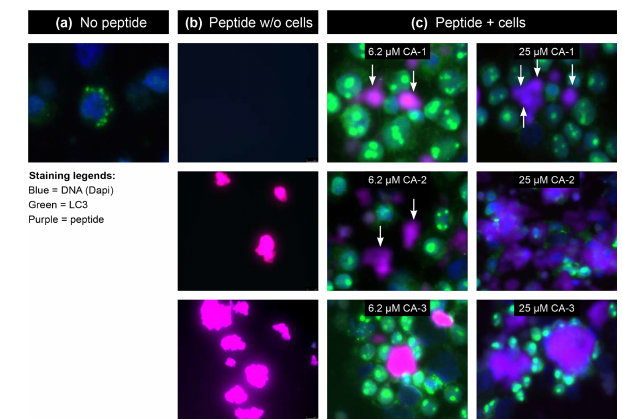
Figure 14. Monitoring the uptake and aggregation of bio- orthogonal, site-specific citrullinated MOG peptides via confocal microscopy . Human EBV-infected BLCs were incubated for 48 h with either none (peptide conc. 0µM), 6.2 or 25µM of unmodi- fied MOG34-56 (peptide 10), or peptide citrullinated at positions 41 + 46 (peptide 11) or positions 46 + 52 (peptide 12) (highlighted in yellow). Cells were fixed with 4% paraformaldehyde and pro- cessed for immunofluorescence with the following primary anti- bodies; the nucleus was stained with DAPI (blue) and LC-3 was used as an autophagosome marker (green). The bio-orthogonal pep- tides were stained using CuAAC chemistry with azide Alexa-647 (Thermo Fisher, the